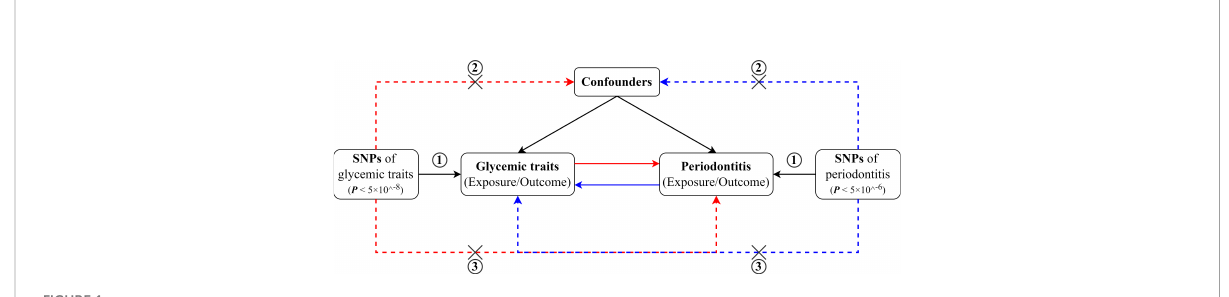
FIGURE 1 Schematic diagram for the bidirectional MR study on the associations between periodontitis and glycemic traits (fasting glucose, HbA1c, and